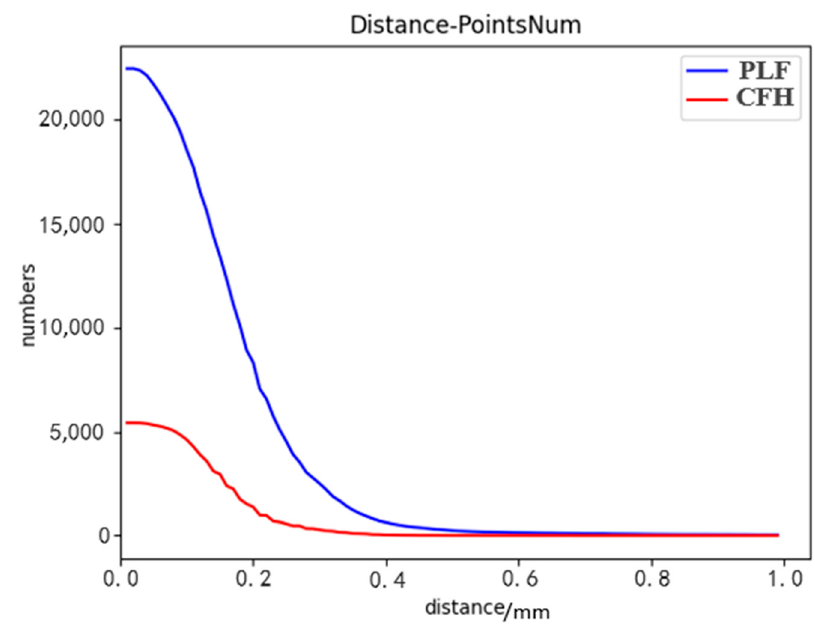
Table 1. Vertical comparison data table of castings.